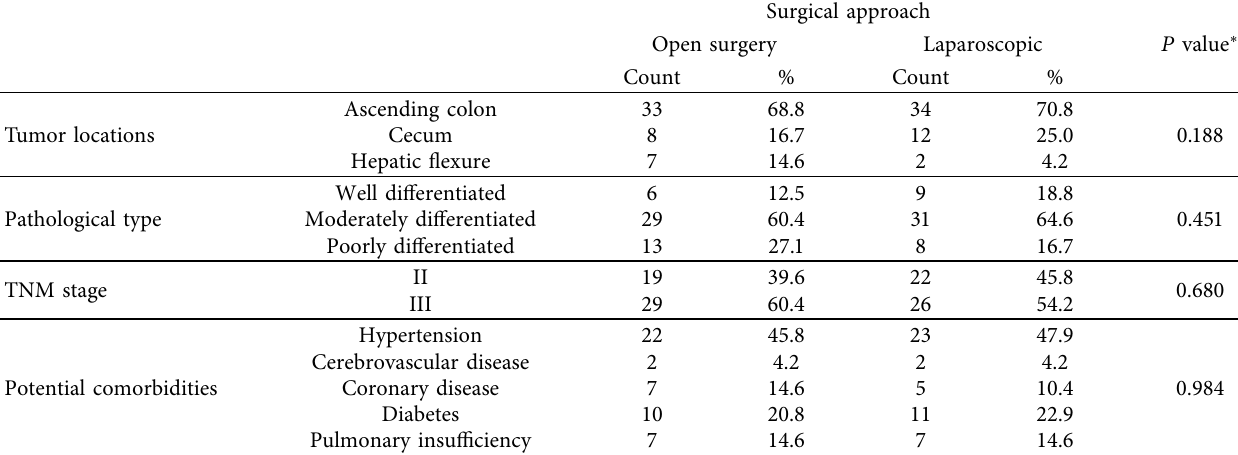
Table 1: Tumor site, pathology, TNM stage, and comorbidities.